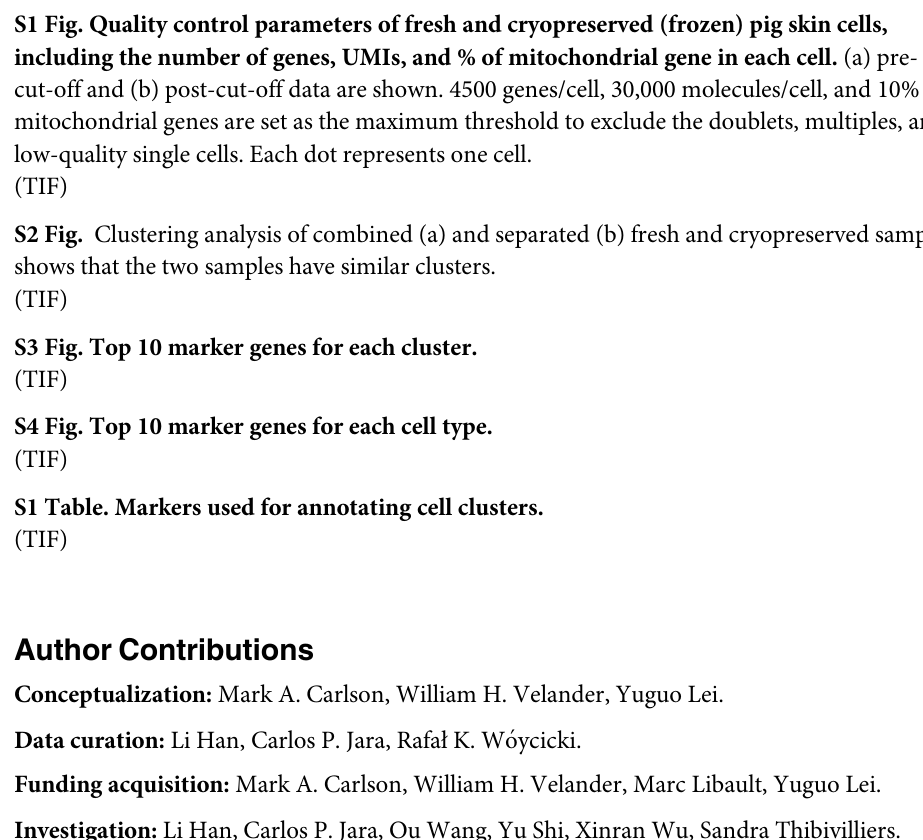
S1 Fig. Quality control parameters of fresh and cryopreserved (frozen) pig skin cells, including the number of genes, UMIs, and % of mitochondrial gene in each cell. (a) pre- cut-off and (b) post-cut-off data are shown. 4500 genes/cell, 30,000 molecules/cell, and 10% mitochondrial genes are set as the maximum threshold to exclude the doublets, multiples, and low-quality single cells. Each dot represents one cell. S2 Fig. Clustering analysis of combined (a) and separated (b) fresh and cryopreserved samples shows that the two samples have similar clusters. S3 Fig. Top 10 marker genes for each cluster. S4 Fig. Top 10 marker genes for each cell type. S1 Table. Markers used for annotating cell